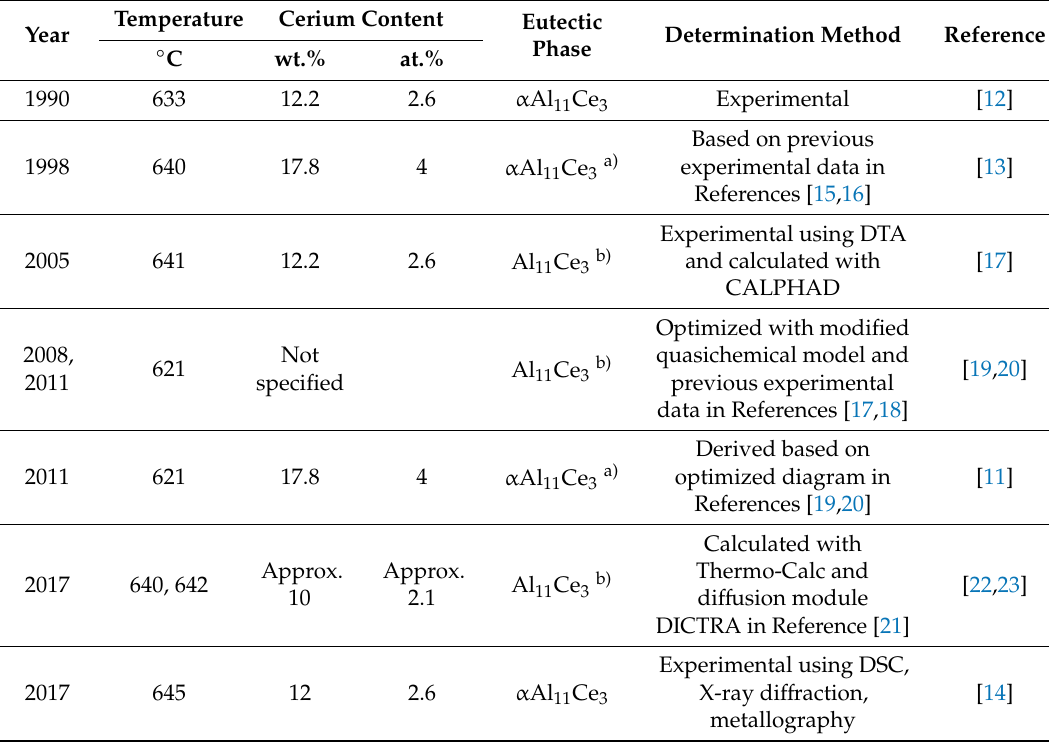
Table 1. Coordinates of the eutectic transformation L ↔ Al + Al 11 Ce 3 in the Al-rich portion of the Al–Ce phase diagram, published within last three decades. Compositions marked with (*) were originally reported, then converted to wt.% / at.% in this